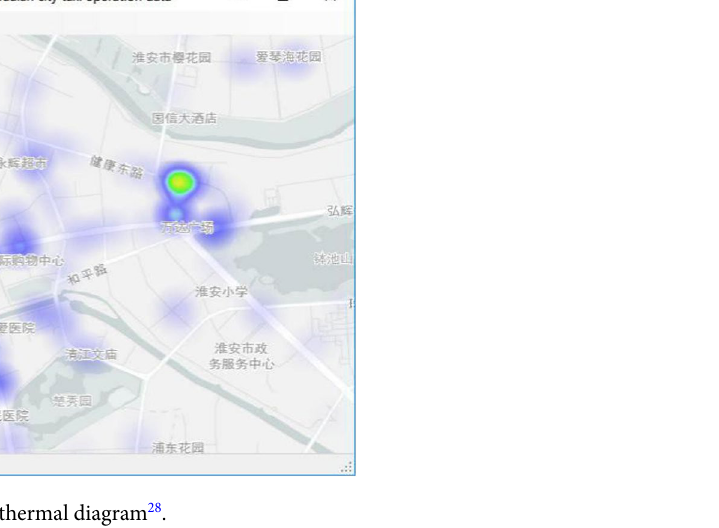
Figure 6. The original thermal diagram 28